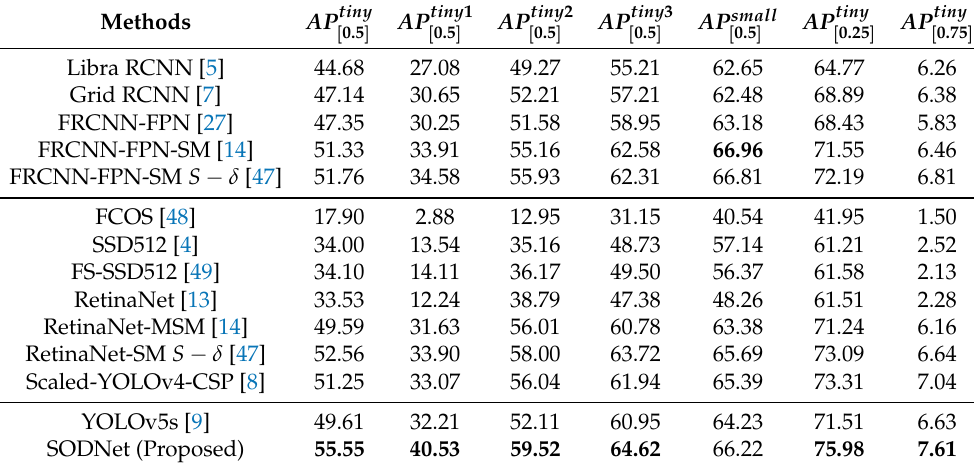
Table 3. Comparisons of APs on TinyPerson test dataset. The best results are marked in bold.